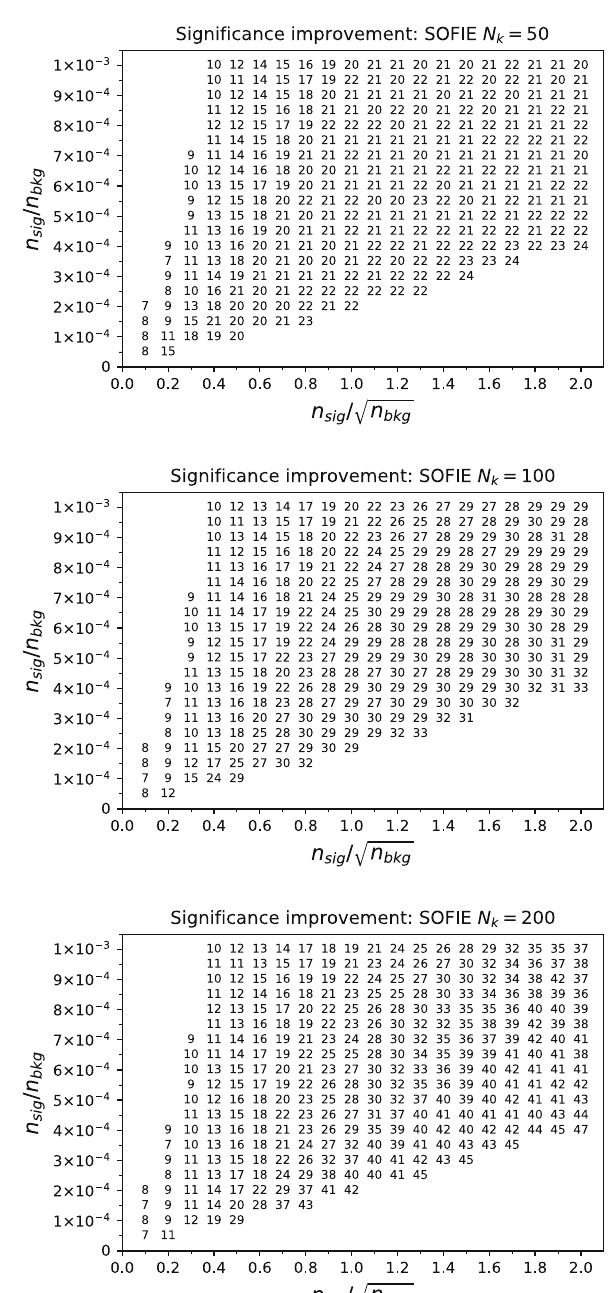
Fig. 14 Significance improvement as a function of n sig / n sig / n bkg , for in-situ mass decorrelation with ε b = 0 .